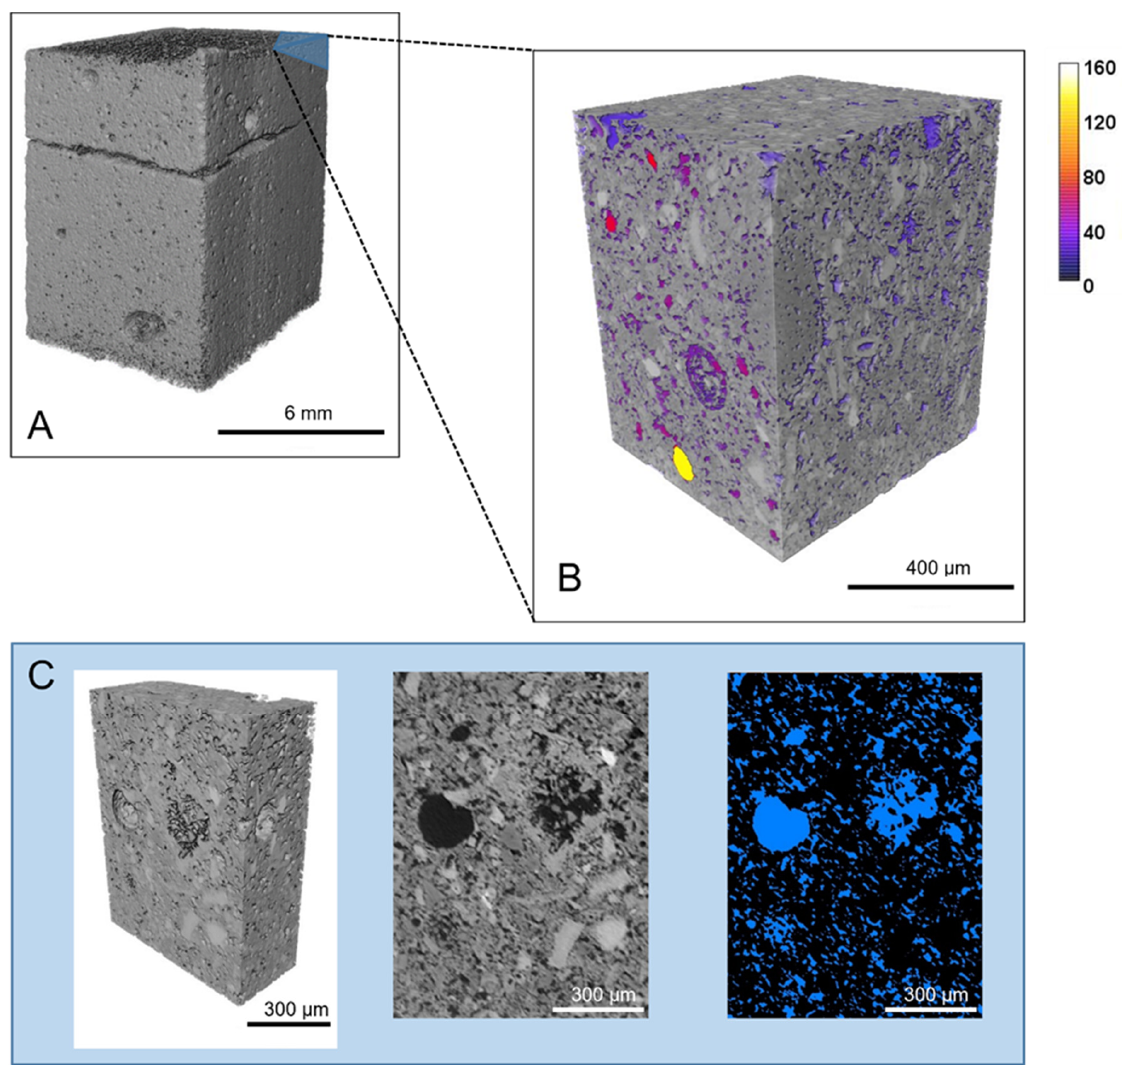
Figure 6. ( A ) Three-dimensional rendering of CFM sample obtained with Nikon micro-CT (voxel size 8.5 µm); ( B ) three-dimensional rendering of a subvolume of the sample shown in A taken from the edge, with a higher resolution (voxel size 1 µm) obtained with VERSA micro-CT scanner. Colors of pores represent local thickness computed areas with Fiji/ImageJ software (bar scale values are in µm). ( C ) Representative 3D section of the subvolume shown in ( B ) along with 2D slice (raw data in the center) and its segmented version (right).